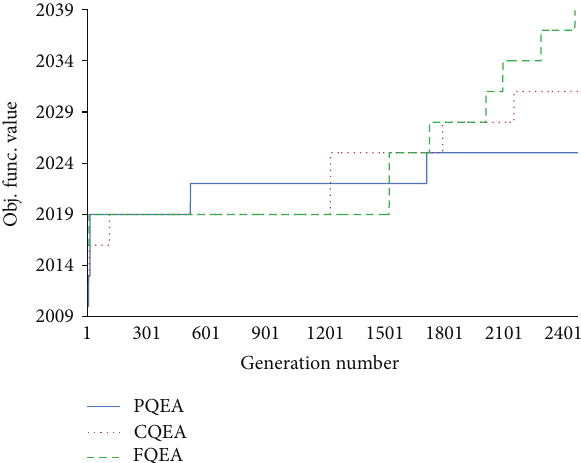
Figure 29: Convergence graph of PQEA, CQEA, and FQEA on 0-1 knapsack problem with profit ceiling data instances with number of items, 𝑀 , being 200 and capacity, 𝐶 , being 5% of total weight.